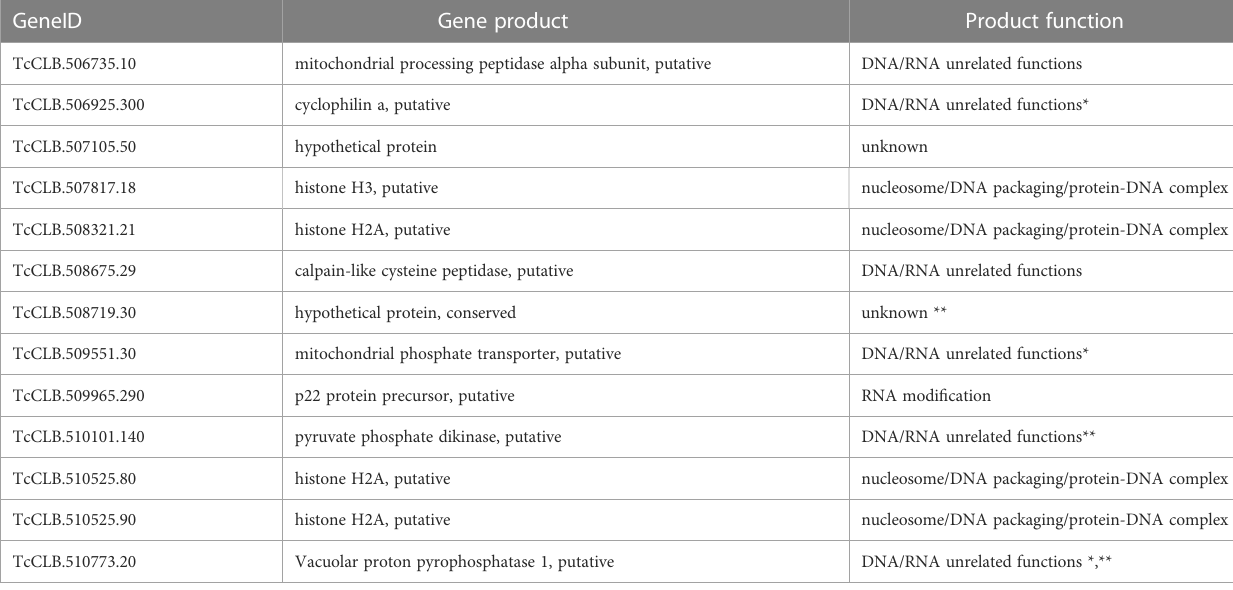
TABLE 3 Downregulated Se ⋂ Si DEGs in the chromatin/chromosome